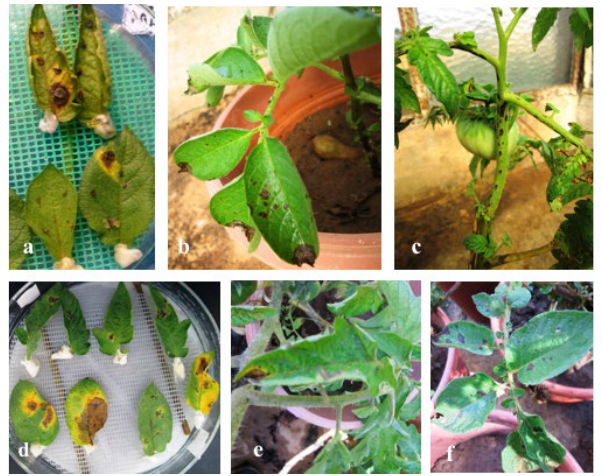
Figure 5. Symptoms on detached leaflets (a, d) and whole tomato (c, e) or potato (b, f) plants inoculated by A. linariae isolate DA002 (a, b and c) or by A. grandis isolate DA009 (d, e and f)